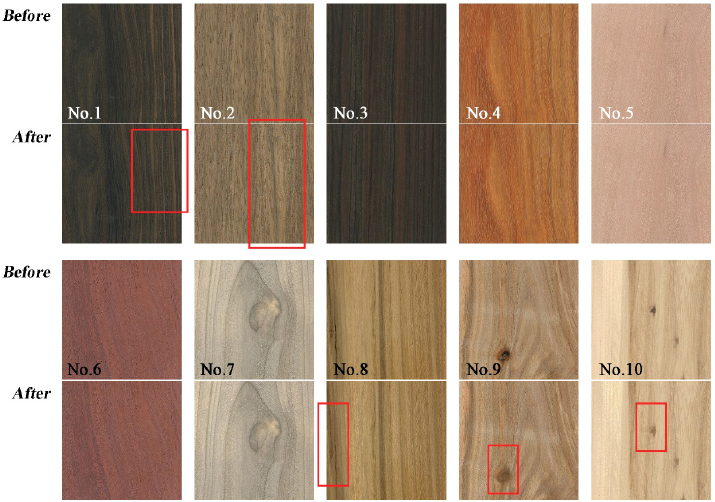
Figure 1. Ten hardwood grain images before and after the Gaussian histogram specification.